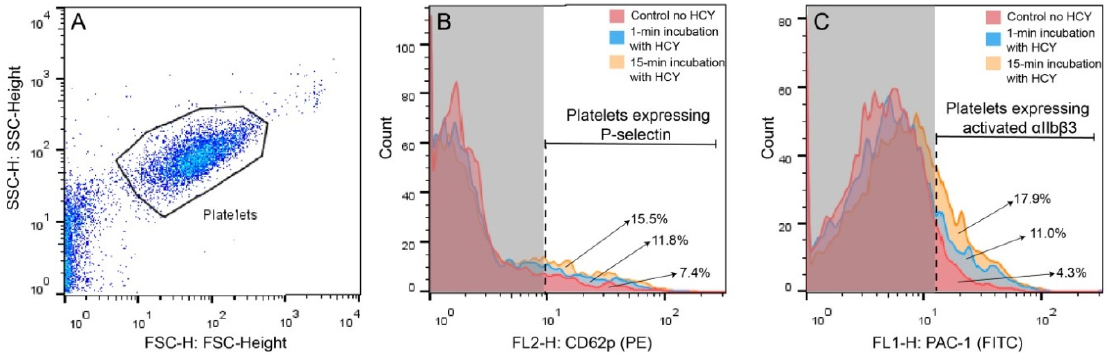
Figure 3. Representative raw data on the flow cytometry of isolated platelets untreated and treated with Hcy. ( A ) Platelets were gated (black closed line) based on the size and granularity using the Forward Light Scatter (FSC) and Side Scatter (SSC) channels, respectively. ( B , C ) Platelets were labeled with anti-human CD62 P phycoerythrin-conjugated antibodies ( B ) or fluorescein isothiocyanate-conjugated PAC-1 antibodies ( C ) before and after addition of 50 μ M Hcy followed by 1-min or 15-min incubation. B and C represent combined histograms showing the fractions (%) of the fluorescent platelets under different experimental conditions. The vertical dashed line separates the non-fluorescent (on the left) and fluorescent signals within the platelet gate. Each histogram contains 5000 total counts. Table 1. Effects of exogenous Hcy (50 μ M) on the expression of platelet activation markers. Markers